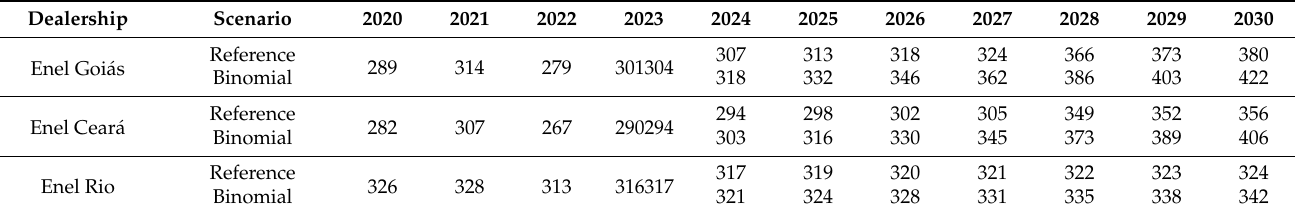
Table 16. Projected revenue of part B—VPB (0), in million